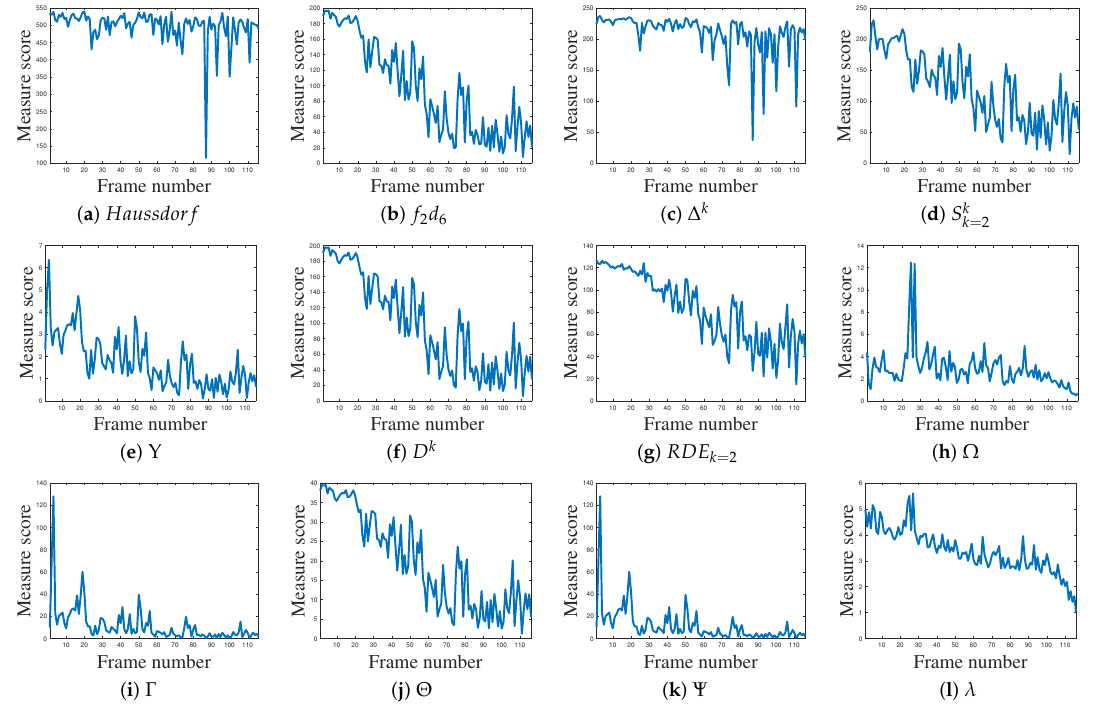
Figure A3. Behaviors of non-normalized localization metrics on real experiment with noisy images tied to video 4 (V4), with images of size 720 × 1280, see Figure 6. Plots from